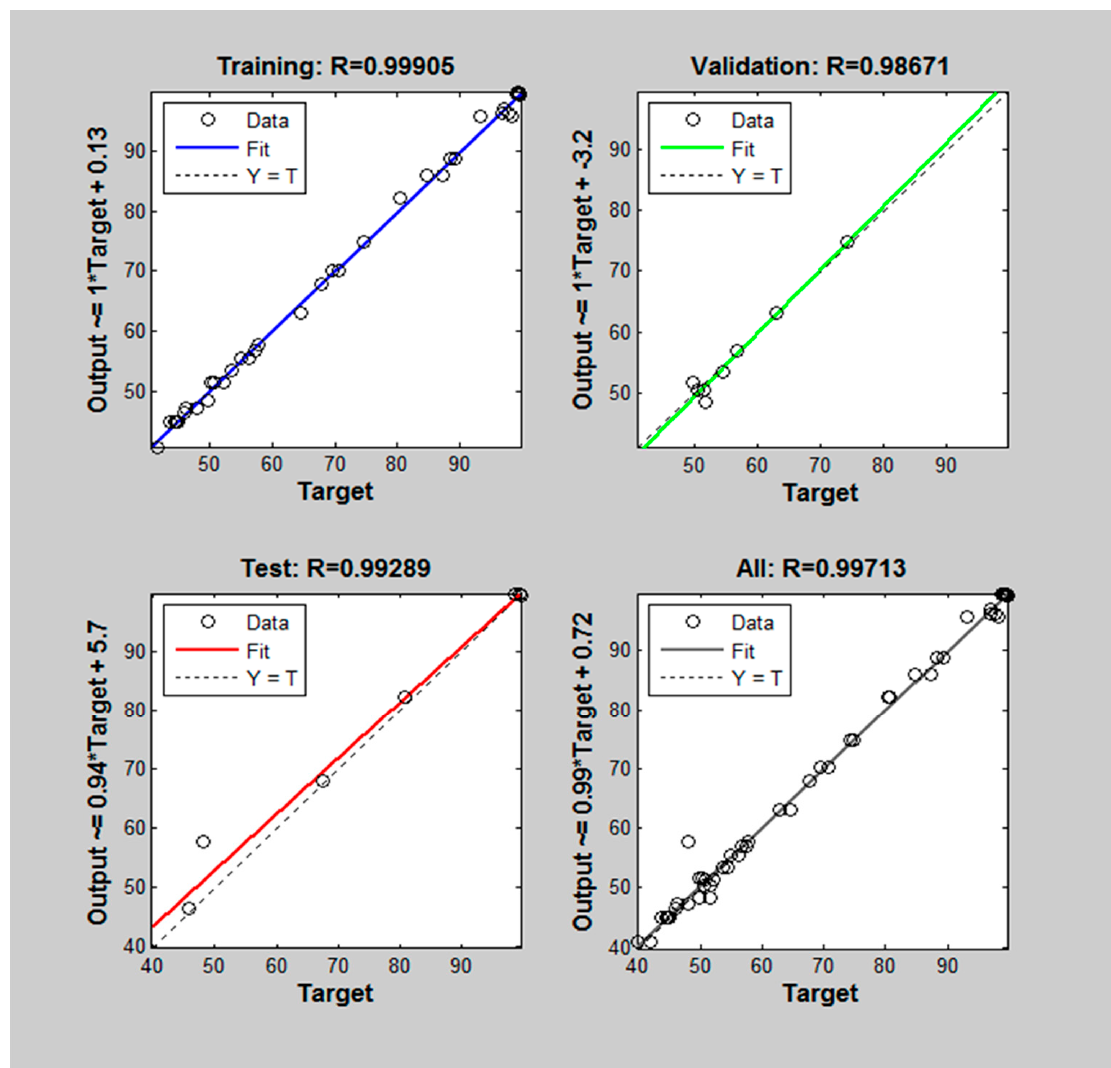
Figure 3. Correlation plots between the output and target values for training, validation, and testing. The results of the 250 µm passing are plotted as an example.